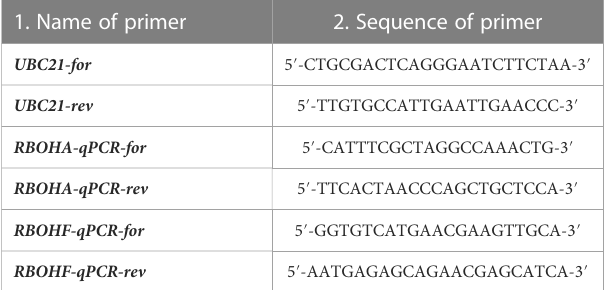
TABLE 1 Primers used for RT-qPCR analysis on whole WT and rbohd